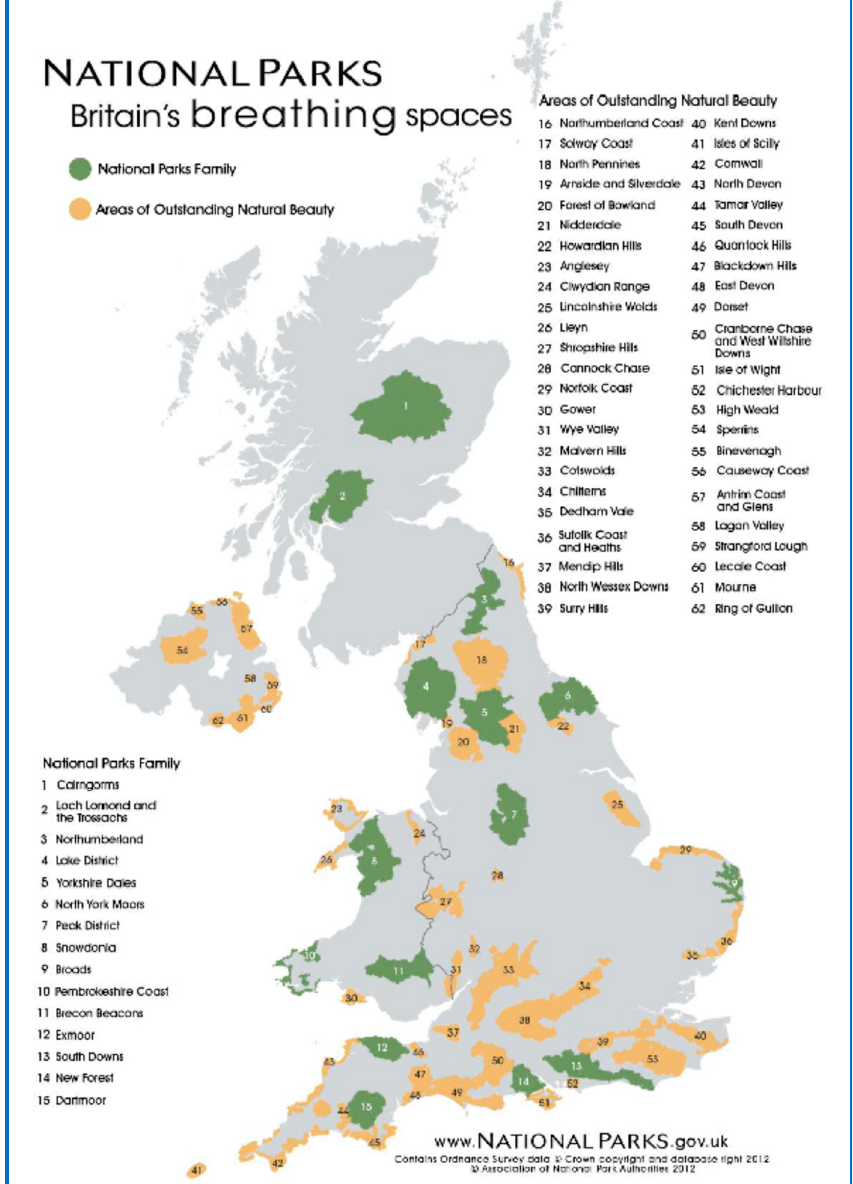
Figure 1. National Parks and AONBs in Great Britain (www.nationalparks.gov.uk ) (accessed on 15 January 2022).